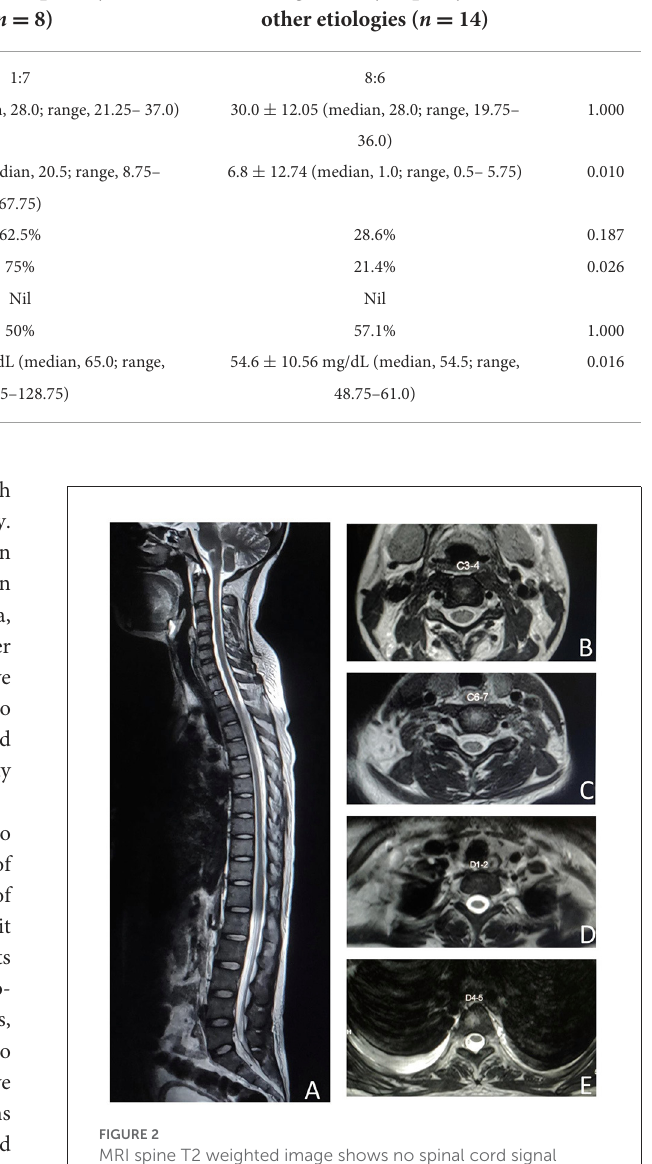
transverse myelitis [LETM] in SLE). (iii) change in blood- brain barrier (BBB) due to complex interplay of overlapping autoantibodies; and (iv) co-clustering of various intertwining pathophysiological mechanisms (cord inflammation, venous hypertension, and cord ischemia) resulting in hemodynamic compromise (1, 2, 4, 6, 10–12,